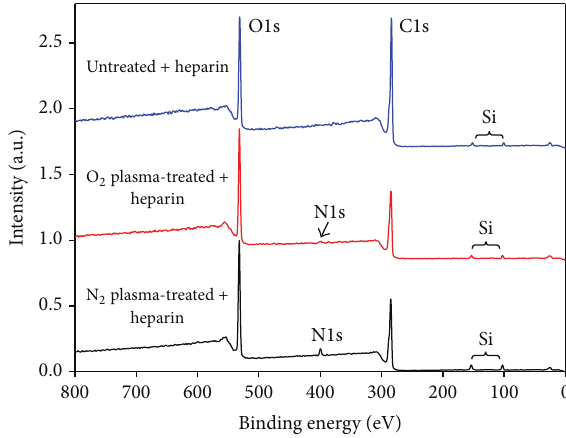
Figure 2: XPS survey spectra of PET samples coated with